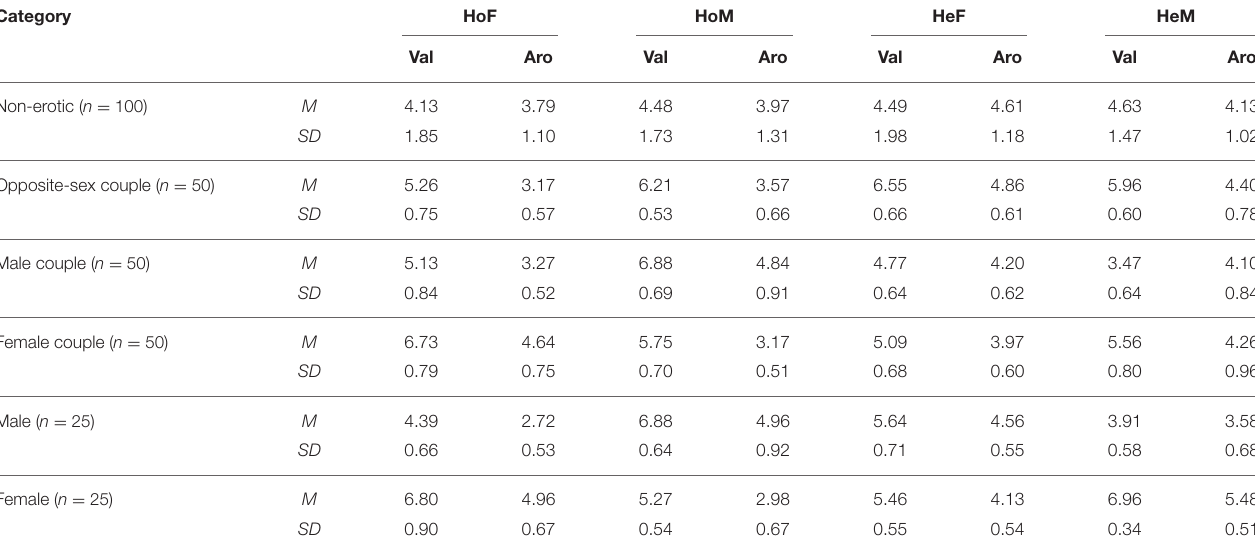
TABLE 1 | Descriptive statistics ( M —mean, SD —standard deviation) in the NAPS ERO calculated for valence (Val) and arousal (Aro) in homosexual females (HoF), homosexual males (HoM), heterosexual females (HeF), and heterosexual males (HeM) for each content category. Category HoF HoM HeF HeM Val